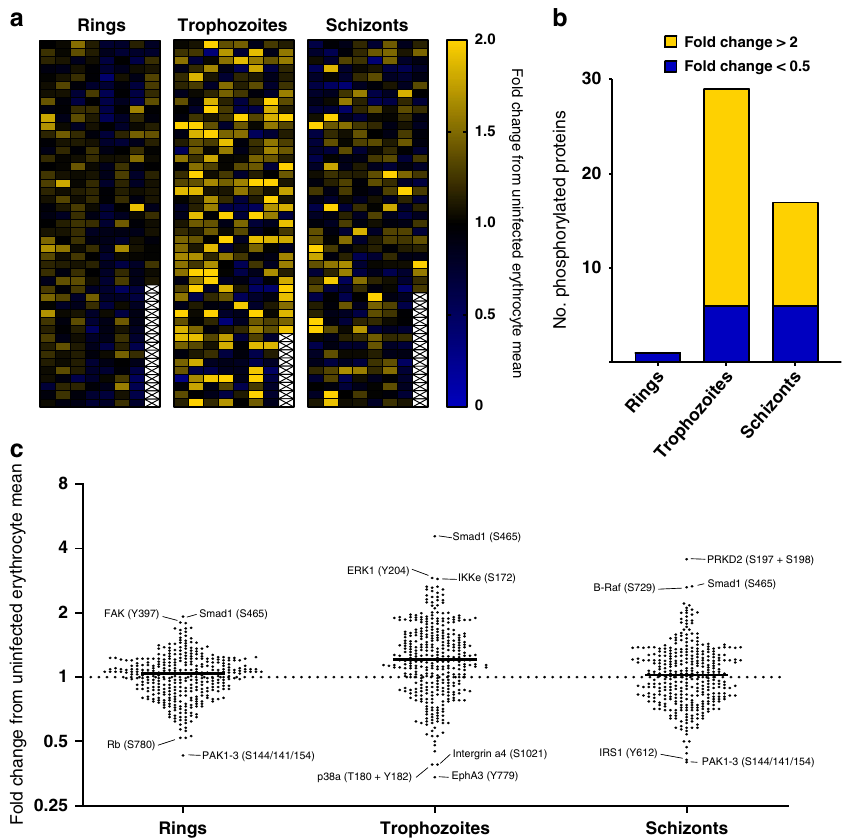
Fig. 2 Microarray data for the ring, trophozoite and schizont stages. a Heatmap of phosphospeci fi c antibody array data for ring-, trophozoite- and schizont-infected cells after the removal of cross-reactive and weak signals. b Phosphorylation-speci fi c signals (post- fi ltering) ranked according to fold change. Yellow represents changes with a fold change > 2; blue represents changes with a fold change < 0.5. Full datasets are presented in Supplementary Data 1 and 2. c Dot plot highlighting differences in phosphosite signals represented as fold change. The largest changes are listed with their associated phosphorylation site. Source data are provided as a Source Data fi